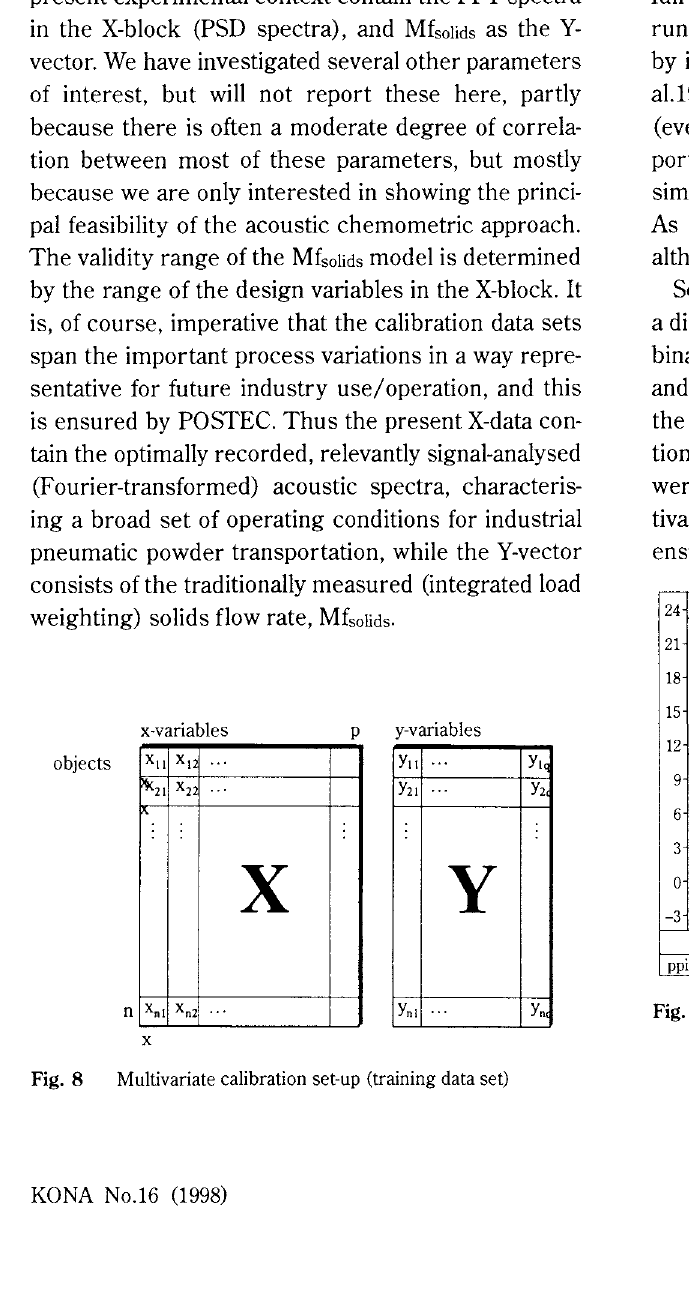
Fig. 9 Predicted vs. measured evaluation plot. Statistics refer to a f.illi:d regression line of the CVS predictions vs. the ref erence measurements, which is used as a measure of deviation from an ideal